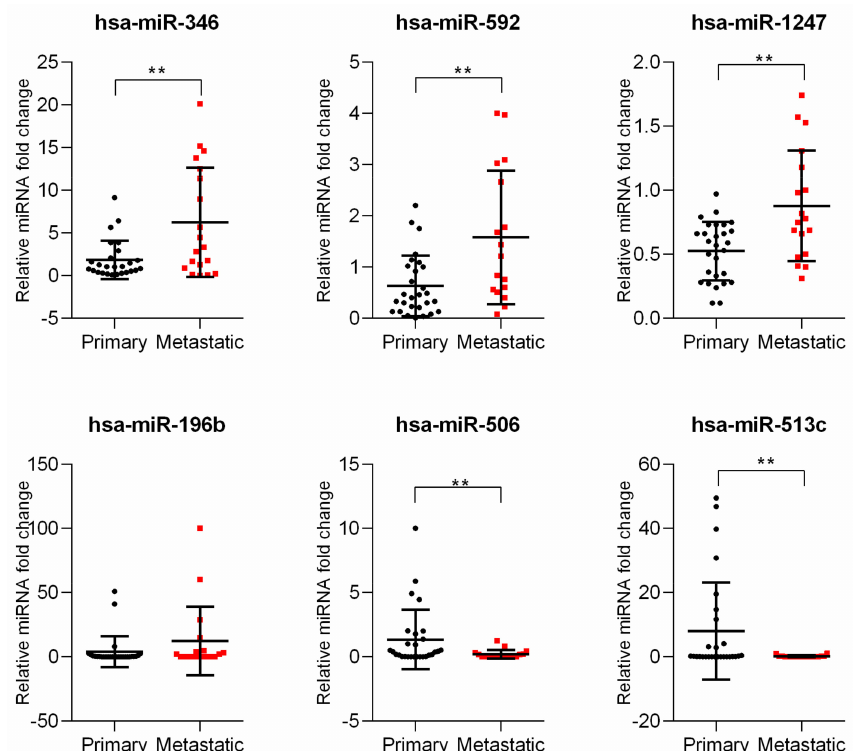
Figure 2. Analysis of miRNA expressed di ff erentially between primary and metastatic uveal melanoma samples. The results are displayed as relative miRNA fold change calculated as log 2 - ∆∆ Ct. Each dot represents an individual patient. The graph represents mean ± SD. The statistical di ff erences between the two groups were analyzed with Mann–Whitney test where: * p < 0.05, ** p < 0.01, *** p < 0.001, **** p <